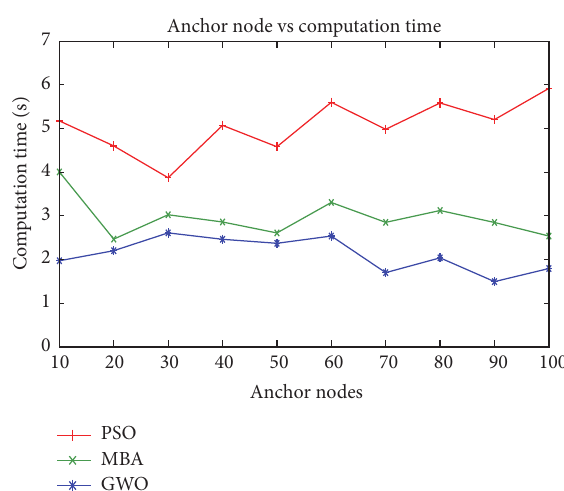
Figure 5: Comparison results of anchor node versus MLE.